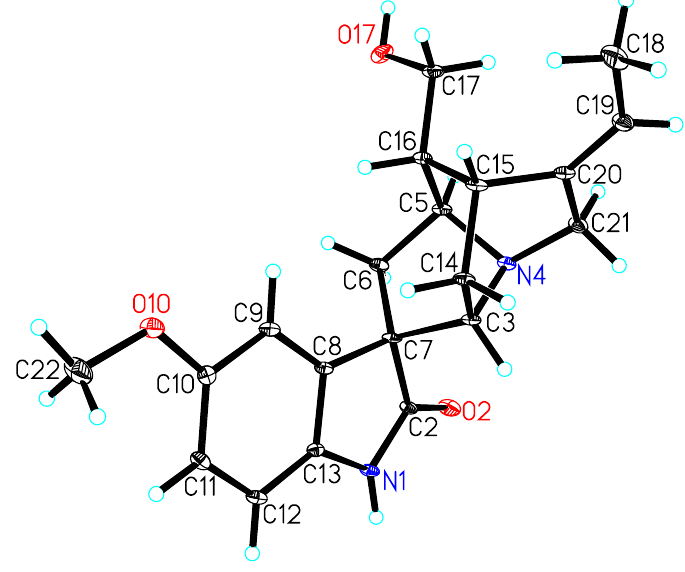
Figure 3. X-ray ORTEP drawing of 1 .